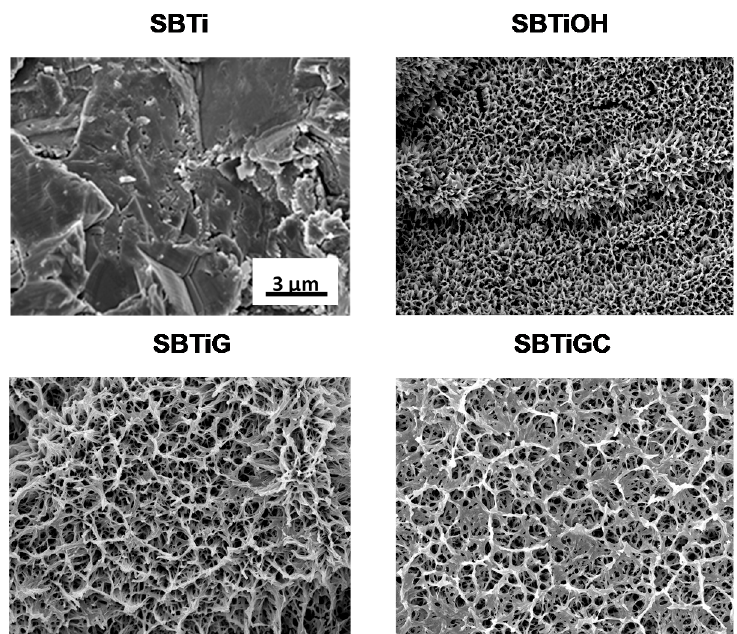
Figure 1. Surface FE-SEM micrographs of test samples.